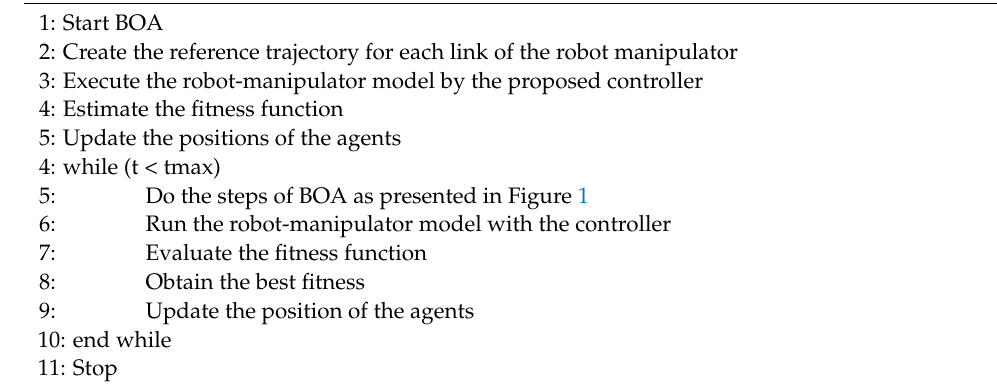
Algorithm 1. The pseudo-code of the proposed BOA to adjust the controller gains